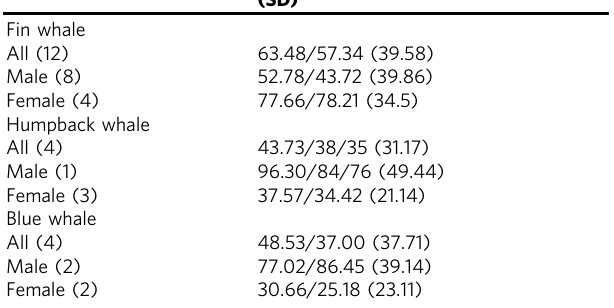
Table 1 Baseline-corrected cortisol, mean/median, and standard deviation (± SD) for large whale earplugs ( N = 20) Whale species and sex ( n ) Percent from baseline mean/median (SD) Fin whale All